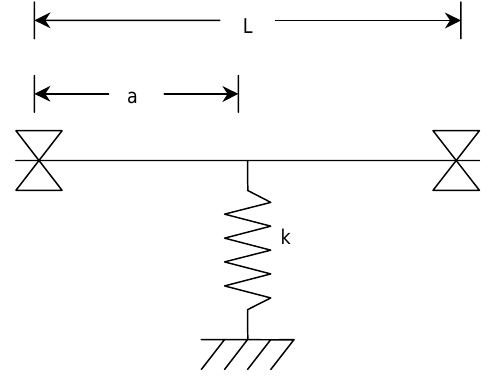
Fig. 4. Simply supported beam with spring support of α . Figures 5 and 6 show such plots for α = 0 .